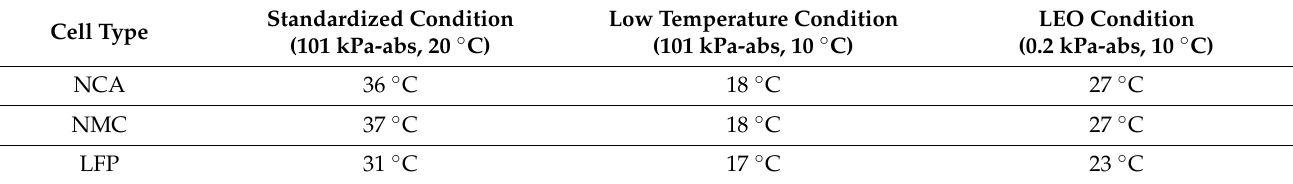
Table 3. Average cell temperature during LEO cycle operating for each cell type and experimental condition. Cell